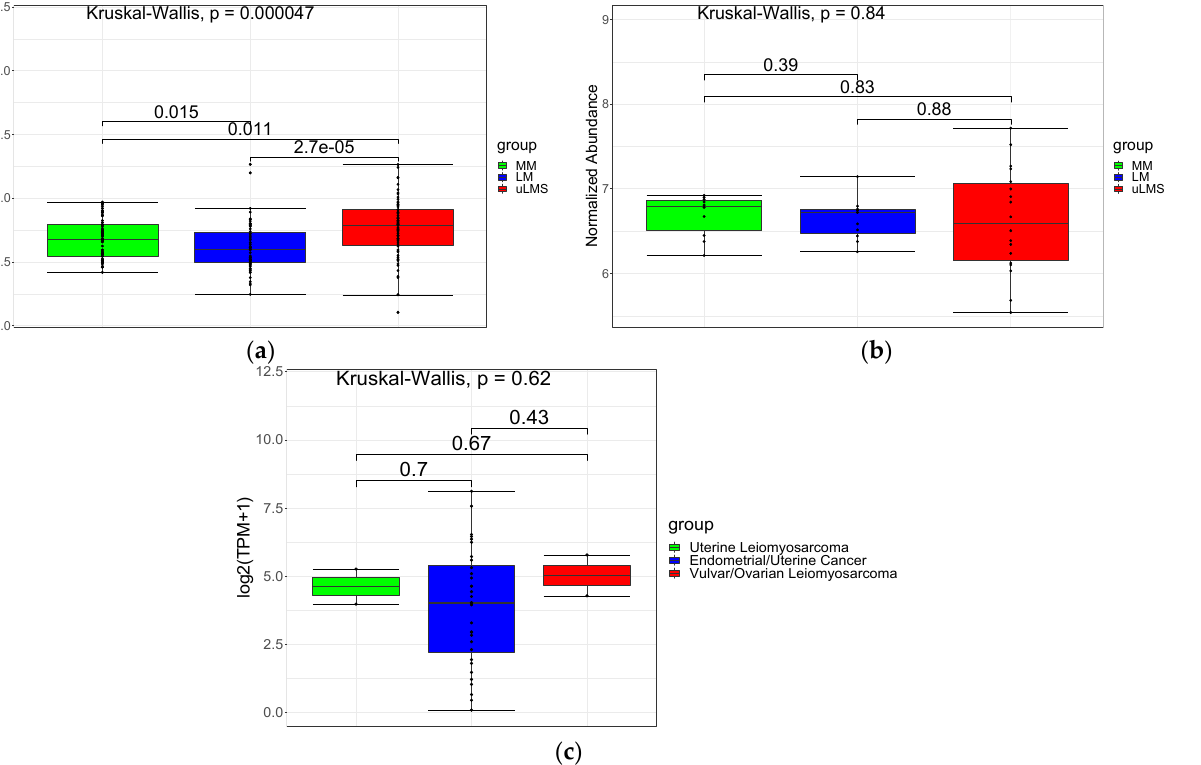
Figure 1. ( a ) PSMB9 expression at gene level between normal adjacent myometrium tissue (MM), leiomyoma (LM) and uterine leiomyosarcoma (uLMS) groups. ( b ) PSMB9 expression at protein level between normal adjacent myometrium tissue (MM), leiomyoma (LM) and uterine leiomyo-sarcoma (uLMS) groups. ( c ) PSMB9 expression at gene level between uterine leiomyosarcoma, endometrial/uterine cancer and vulvar/ovarian leiomyosarcoma cell lines (source: DepMap Portal (https://depmap.org/portal/download/all/, accessed on 10 October 2021).